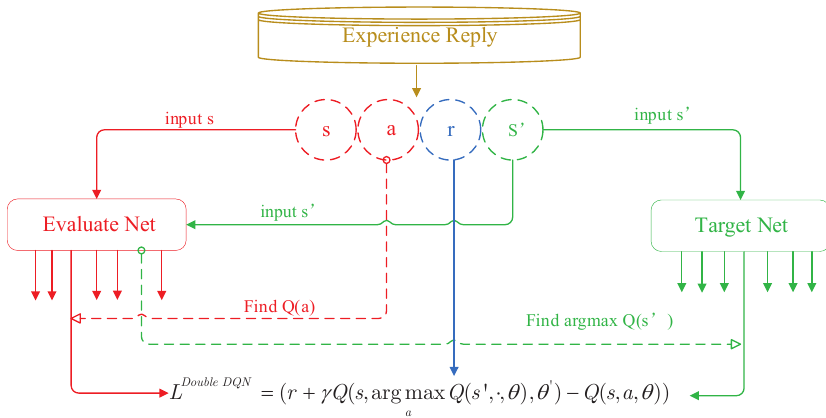
Figure 3. Double DQN algorithm frame